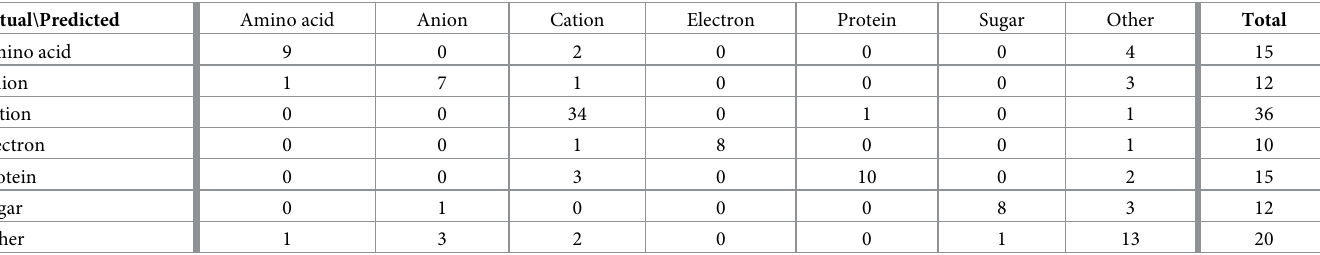
Table 4. Confusion matrix for